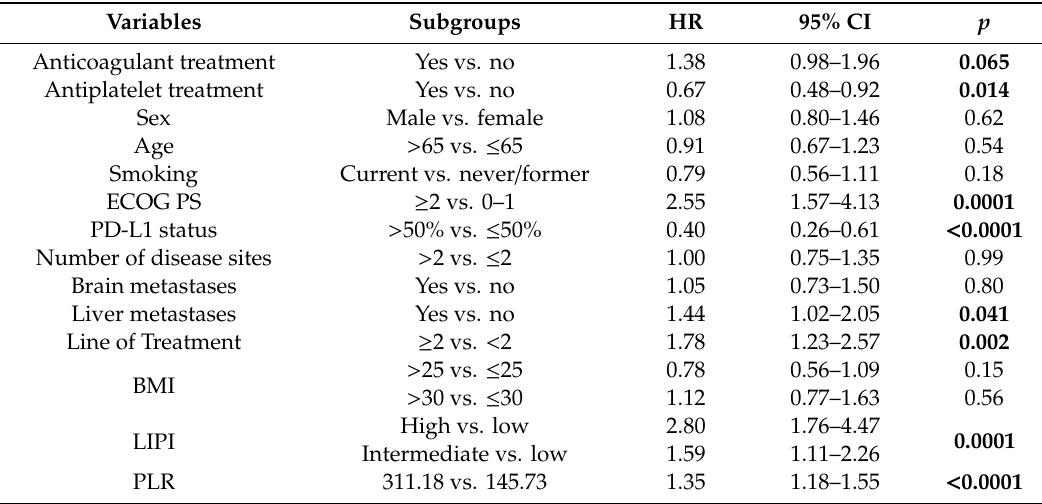
Table 7. Univariate Cox proportional hazards model for progression-free survival.